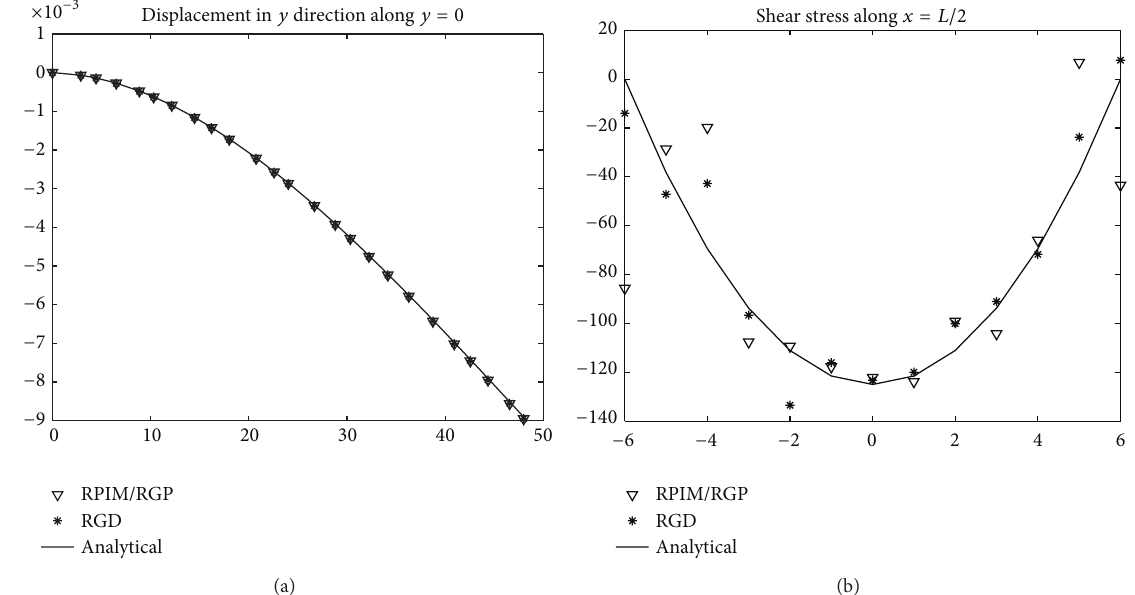
Figure 5: Results for 325 irregular nodes: (a) displacement and (b) shear stress.